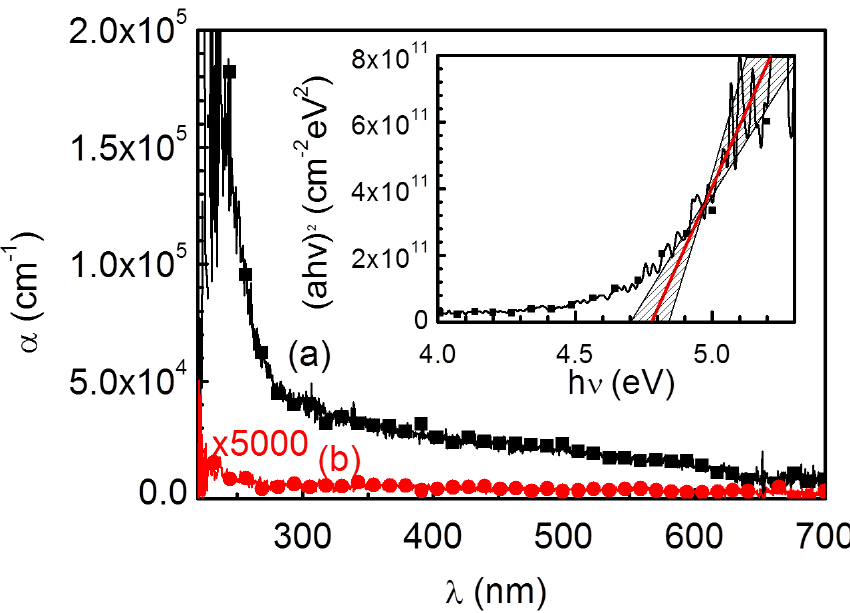
Figure 2. Spectral dependences of the absorption coefficient for ( a ) Ga 2 O 3 thin film and ( b ) the quartz glass substrate. The inset shows the corresponding Tauc plot of Ga 2 O 3 .